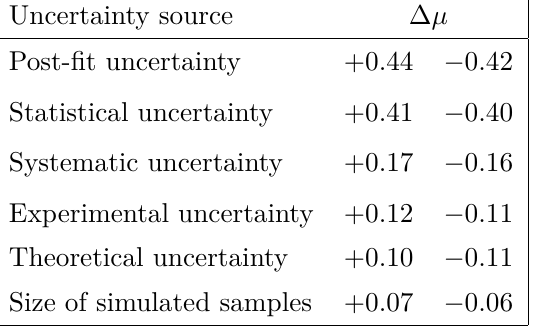
Table 9 . Major sources of uncertainty in the measurement of the signal strength µ and their impact. The total post-fit uncertainty on µ is divided into the statistical and systematic components. The systematic component is further separated into three parts depending on the origin of the different sources of uncertainty: experimental, theoretical, and size of the simulated samples. The uncertainty due to the limited statistics of the simulated samples only affects the VBF category